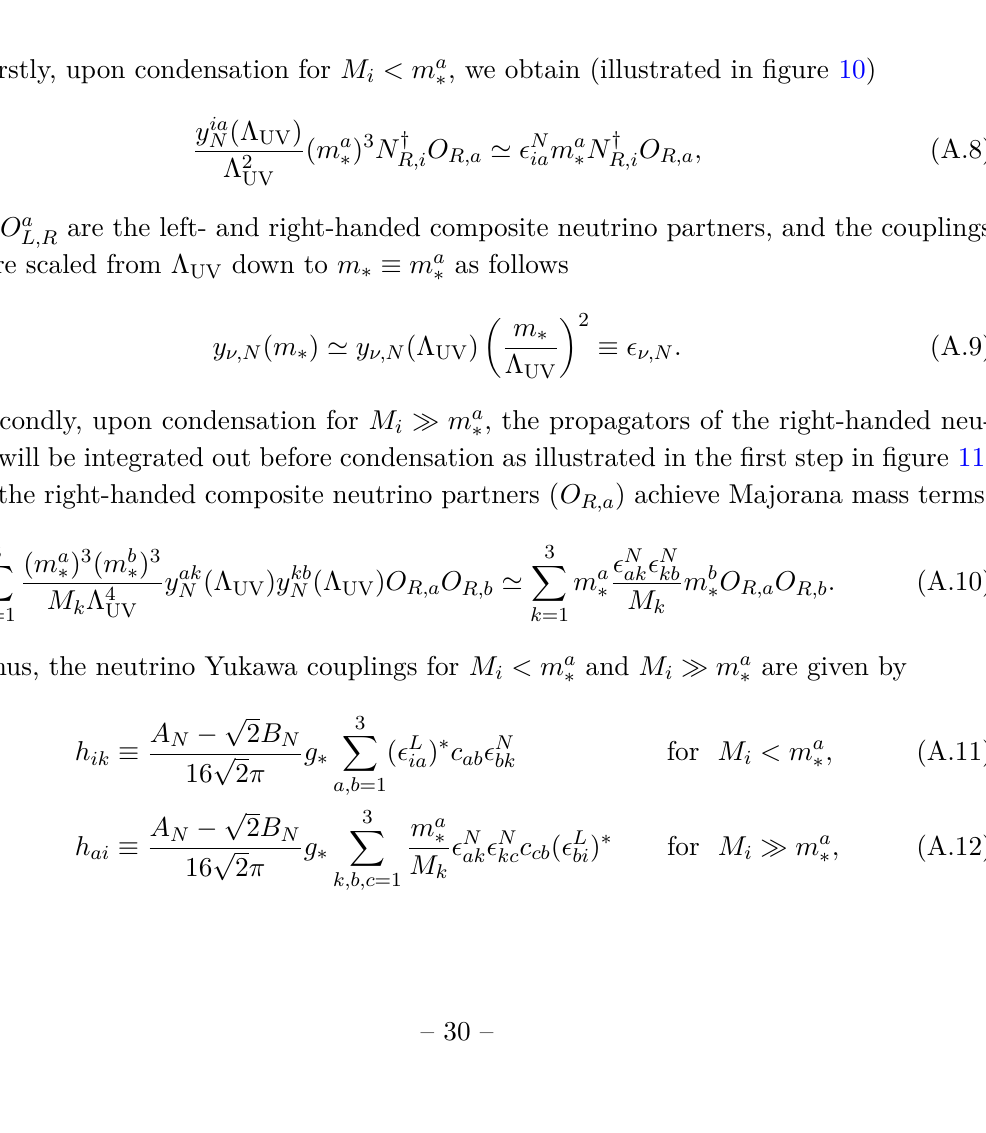
Figure 11 . The generation of the Majorana masses of the right-handed composite neutrino part- ners, O R,a , from the four-fermion interactions in eq. (A.7) when M i (cid:29) m ∗